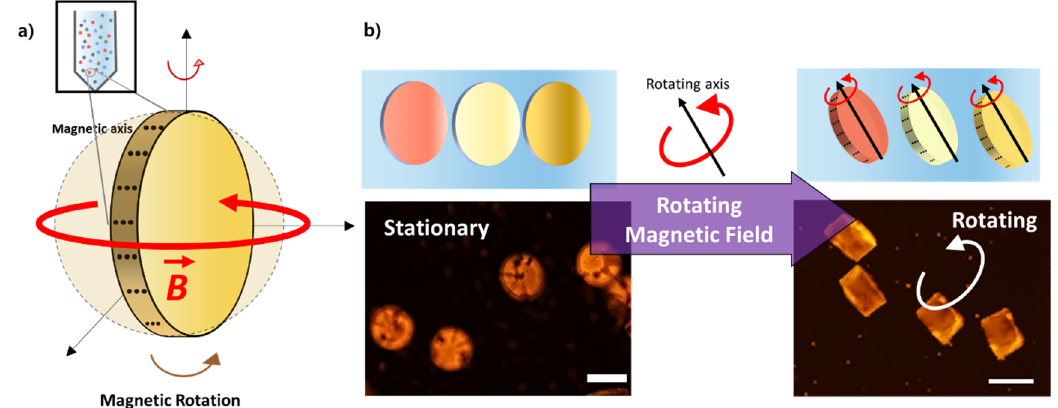
Figure 1. Patterned magnetization of polymer microparticles enables efficient microscale mixing. ( a ) A schematic of a microparticle embedded with aligned magnetic nanoparticles and its rotation. ( b ) 3D schematic and fluorescence micrograph of efficient mixing under rotating magnetic field. Scale bar, 100 µm.